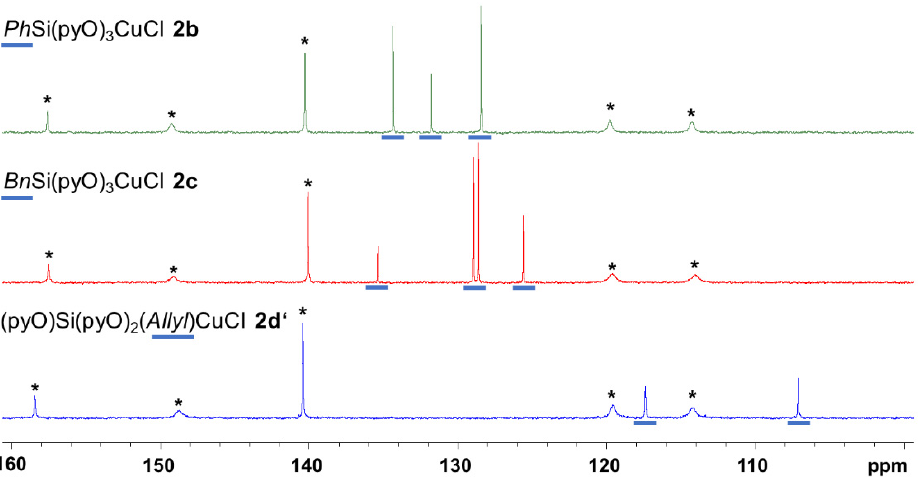
Figure 7. Aryl and olefin section of the 13 C NMR spectra of (from top to bottom) 2b , 2c and 2d ′ (as solutions in CDCl 3 , all referenced to internal SiMe 4 at 0 ppm, cf. Figures S10, S13, S18 in the Supplementary Materials). The asterisks (*) indicate corresponding signals of their pyO moieties, the underbars indicate the relevant 13 C signals of the different hydrocarbyl substituents Ph, Bn and Allyl, respectively.